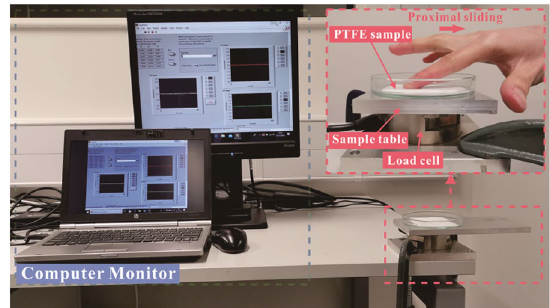
Figure 2 Experimental set-up for active finger